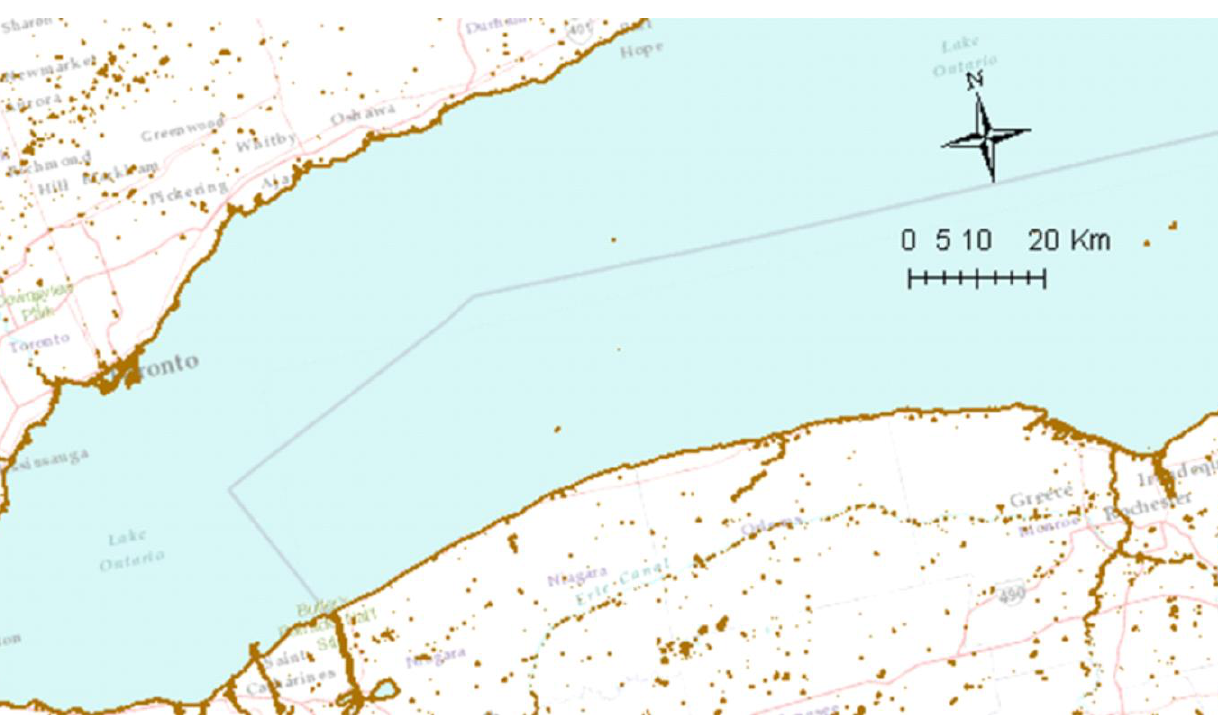
Figure 6. Coast line in